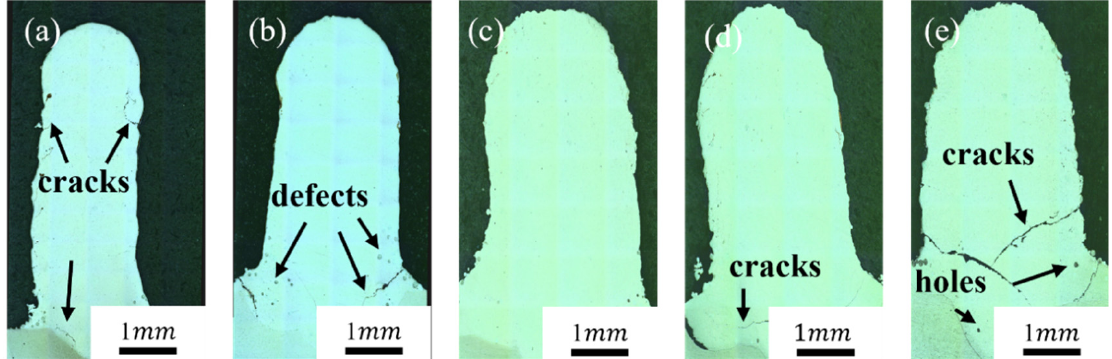
Figure 5. OM image of cross-sectional morphology of thin-walled parts before etching at different processing parameters. ( a ) E l = 2.8 J/mm, ( b ) E l = 3.2 J/mm, ( c ) E l = 3.6 J/mm, ( d ) E l = 4.0 J/mm, ( e ) E l = 4.4 J/mm.